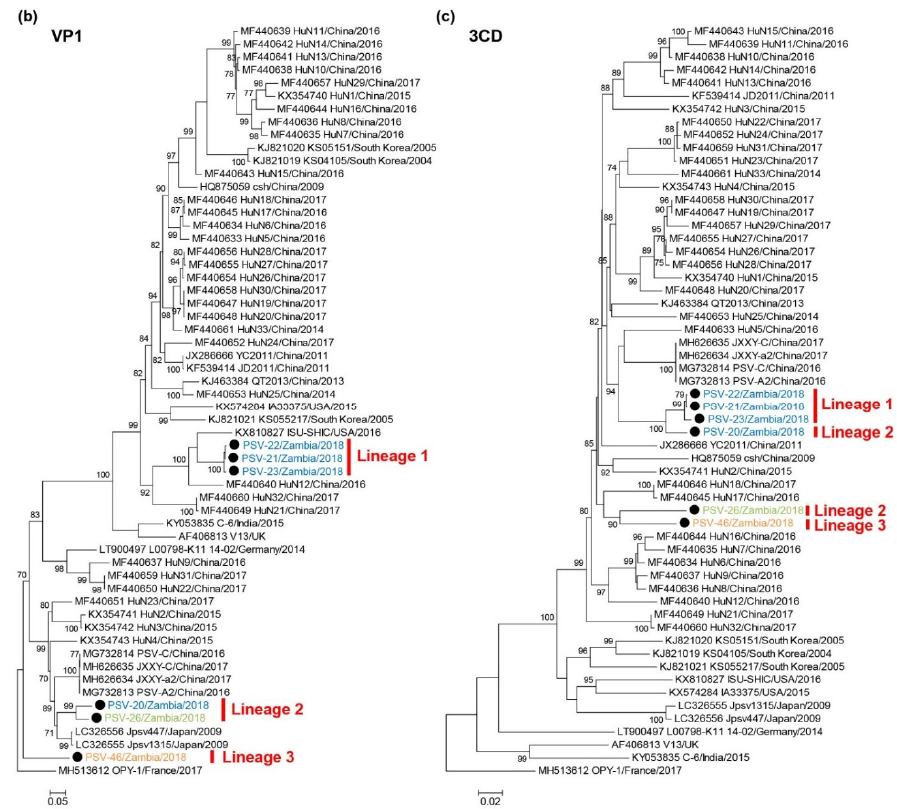
Figure 2. Phylogenetic analysis of PSVs. Based on 6969–7014 nucleotide complete open reading frame (ORF) sequences ( a ), 855–894 nucleotides for VP1 ( b ), and 1929-1932 nucleotides for 3CD ( c ), the trees were constructed using the maximum likelihood method with the GTR + G + I model and 1000 bootstrap replications. Bootstrap values greater than 70% are shown on the interior branch nodes, and clades and lineages are indicated on the tree. The scale bar indicates the number of substitutions per site. Black circles represent the PSVs isolated in this study. Zambian strain names are labeled with different colors as follows: PSV-20, PSV-21, PSV-22, and PSV-23 isolated in Farm A are in blue, PSV-26 isolated in Farm B is in green, PSV-46 isolated in Farm D is in orange.